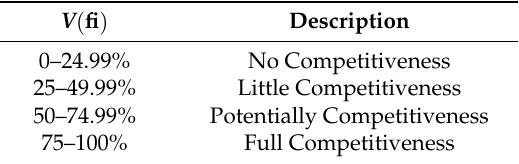
Table 4. Scales rating.